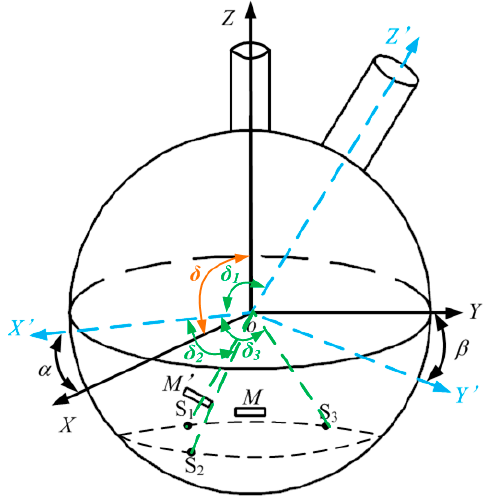
Figure 2. Schematic diagram of measurement model.